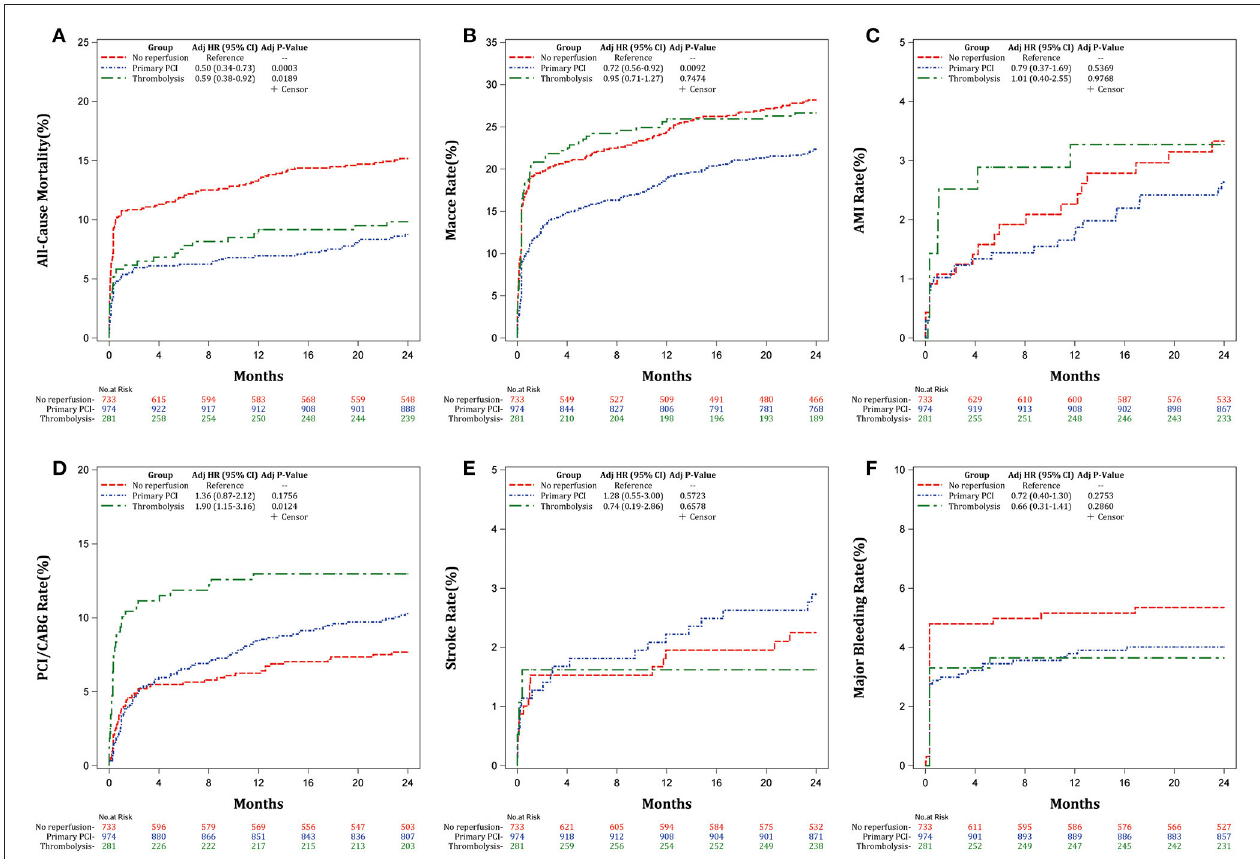
FIGURE 3 | Adjusted Kaplan-Meier estimates of the cumulative incidence of the outcomes after 2-years follow-up. (A) All-cause mortality, (B) MACCE, (C) AMI, (D) Revascularization, (E) Stroke, and (F) Major bleeding.